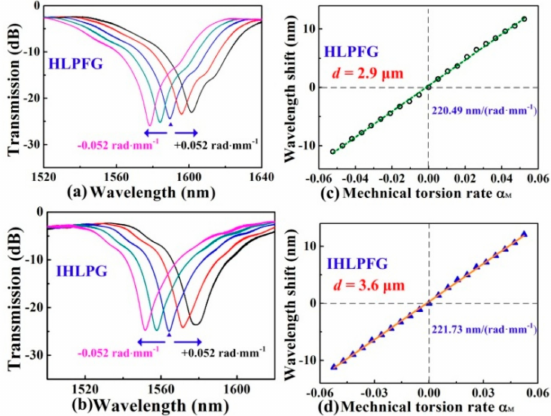
Figure 37. Transmission spectrum evolution of the ( a ) HLPFG and ( b ) I-HLPFG in PCF with air-hole diameters of 2.9 and 3.6 µ m, respectively; measured resonant wavelength shift of the ( c ) HLPFG and ( d ) I-HLPFG as a function of the mechanical torsion